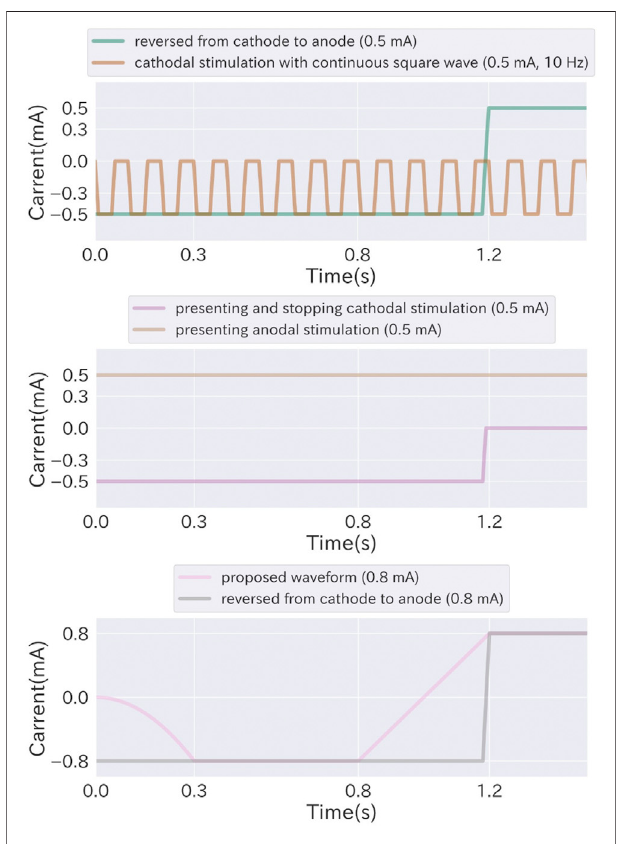
FIGURE 5 | Waveform used in the preliminary Experiments. (A) and (B) Preliminary Experiment 1, (C) Preliminary Experiment 2.